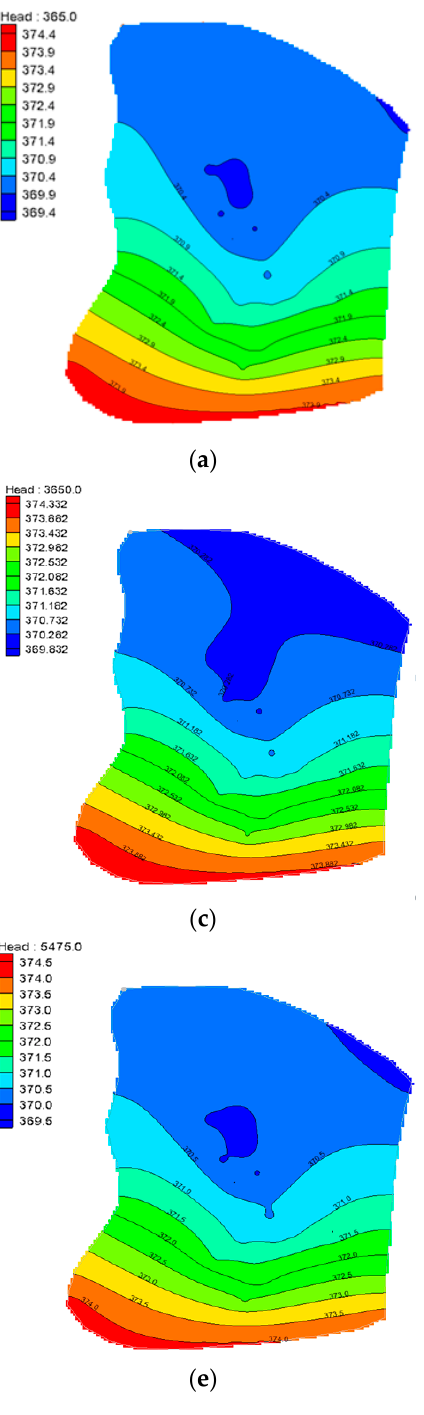
Figure 9. Distribution of water level and flow field at different simulation times. ( a ) Simulates the water level after 3 years under nomal pumping conditions ( b ) Simulates the water level after 5 years under nomal pumping conditions ( c ) Simulates the water level after 10 years under nomal pumping conditions ( d ) Simulates the water level after 13 years under nomal pumping conditions ( e ) Simulates the water level after 15 years under nomal pumping conditions ( f ) Simulates the water level after 20 years under nomal pumping